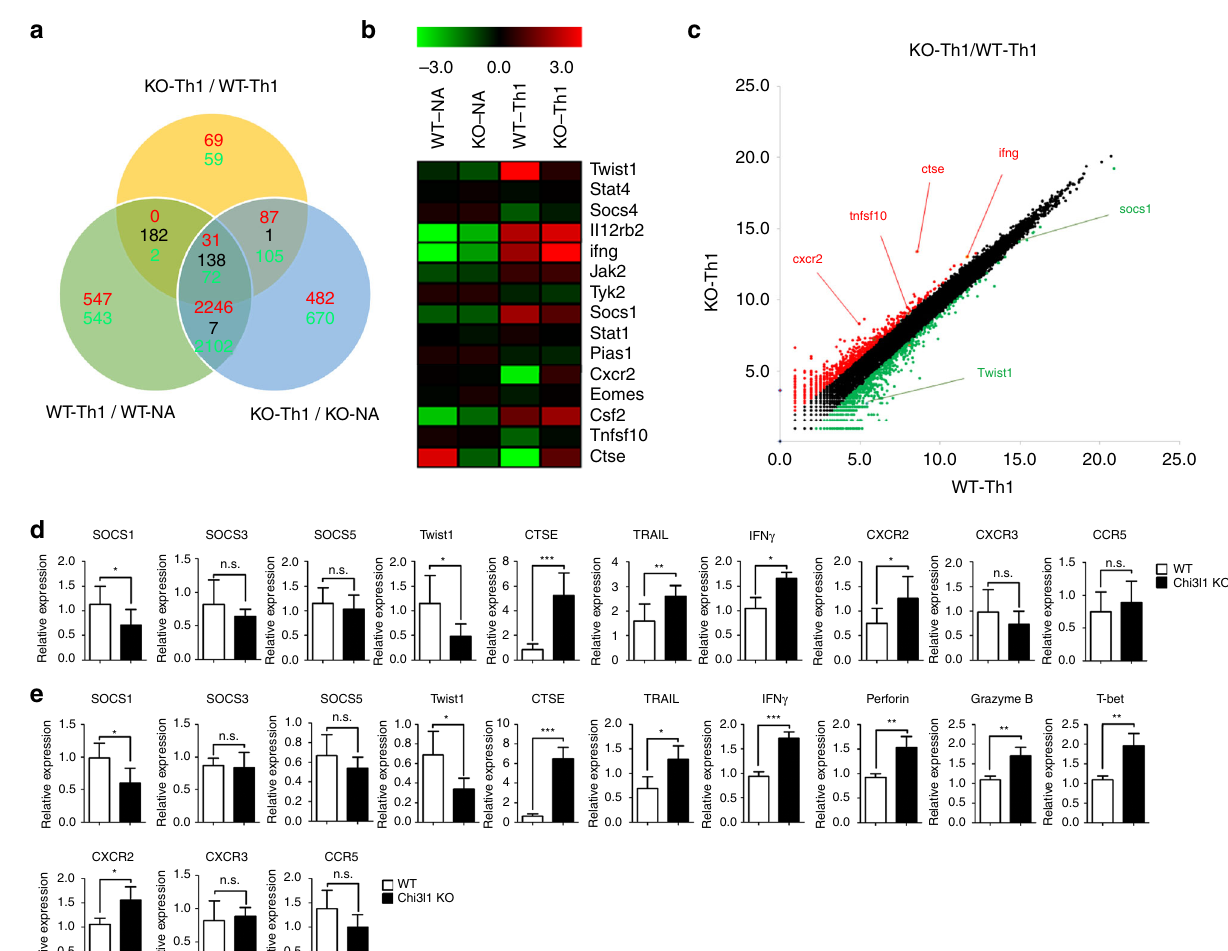
Fig. 5 RNA transcriptomes of Chi3l1 KO T cells. a 100-bp pair-ended RNA-sequencing in naïve, Th1-skewed WT, and Chi3l1 KO CD4 T cells. The number of up-regulated genes were indicated as red, and down-regulated genes were indicated as green in each comparative analysis. b Heatmap analysis of genes of interest. c Scatterplot indicates either of over than two-fold up-regulated and down-regulated genes in WT Th1 versus Chi3l1 KO Th1 comparison. d Expression of genes of interest related to cytotoxicity and the IFN γ signaling pathway in Th1 cells were con fi rmed by quantitative RT-PCR. Each gene expression level was normalized to β -actin, and represented as relative expression to WT. e Quantitative RT-PCR was performed in activated CD8 T cells. Each gene expression level was normalized to β -actin, and represented as relative to WT. Data are mean ± SD of ten sets of independent experiments ( n = 20). n.s., not signi fi cant; * p < 0.05, ** p < 0.01, *** p < 0.001 (two-tailed Student ’ s t